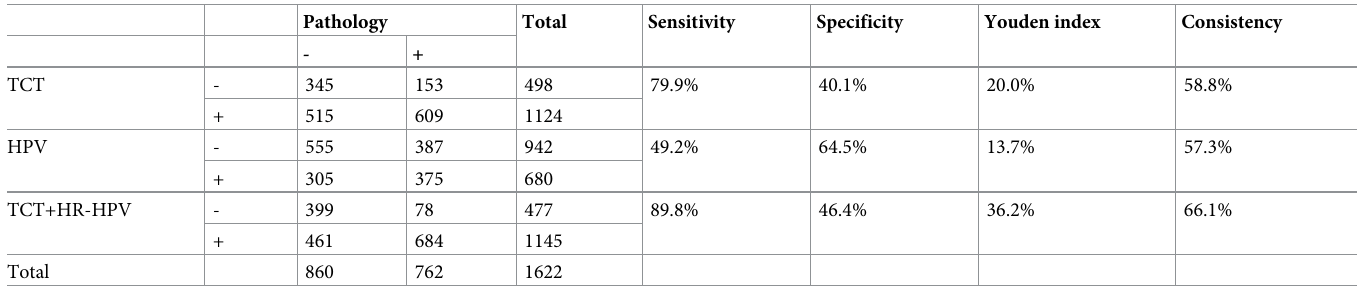
Table 5. Analysis of the screening effectiveness of different strategies for 1622 patients with cervical